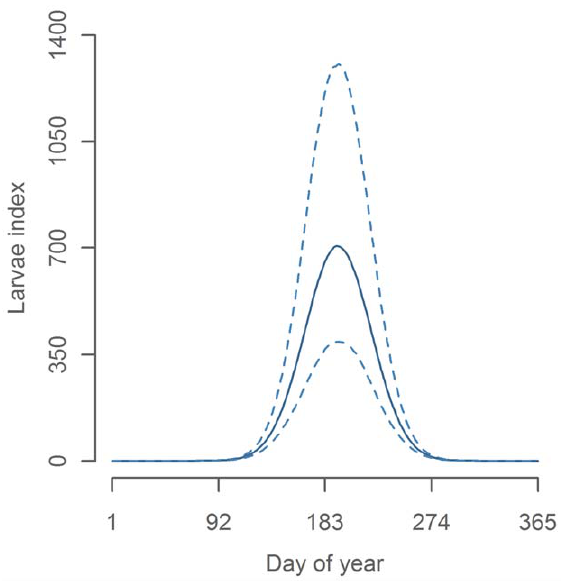
Figure 5. Seasonal effect on CPR larvae index.